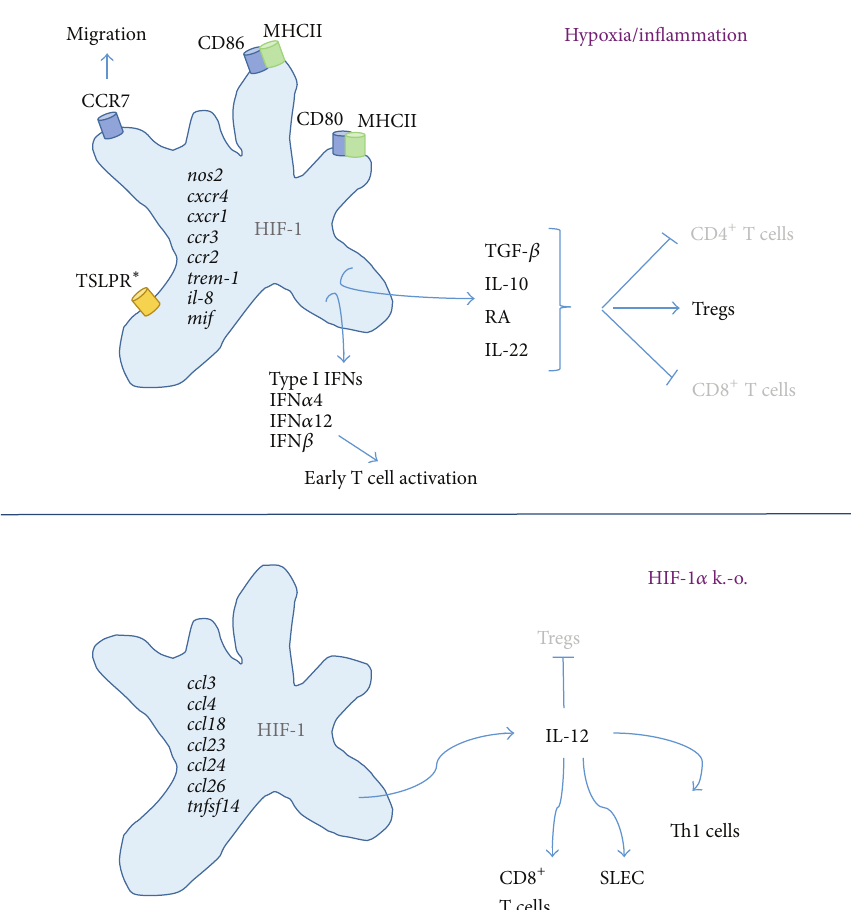
Figure 1: Features of dendritic cells in the presence or absence of active HIF-1 𝛼 . Dendritic cells expressing HIF-1 𝛼 have been shown to induce costimulatory molecules (CD80, CD86, and MHCII/HLA class II) under inflammatory hypoxic conditions. Transcripts of nod2, cxcr4, cxcr1, ccr3, ccr2, trem-1, il-8 , and mif are upregulated. Induced expression of CCR7 favors migration of DC towards secondary lymph nodes. These DCs are potent inducers of Tregs via TGF- 𝛽 , IL-10, RA, and IL-22 although they are able to induce a robust early T cell activation by secretion of type I interferons. Via TSLP, DCs in the gut may be shifted towards a tolerogenic phenotype ( ∗ : TSLPR expression is limited to gut DCs). Dendritic cells lacking HIF-1 𝛼 under inflammatory conditions secrete steady high levels of IL-12 and thereby induce a robust activation of proinflammatory T cell populations. They upregulate transcripts of chemokines to attract more immune